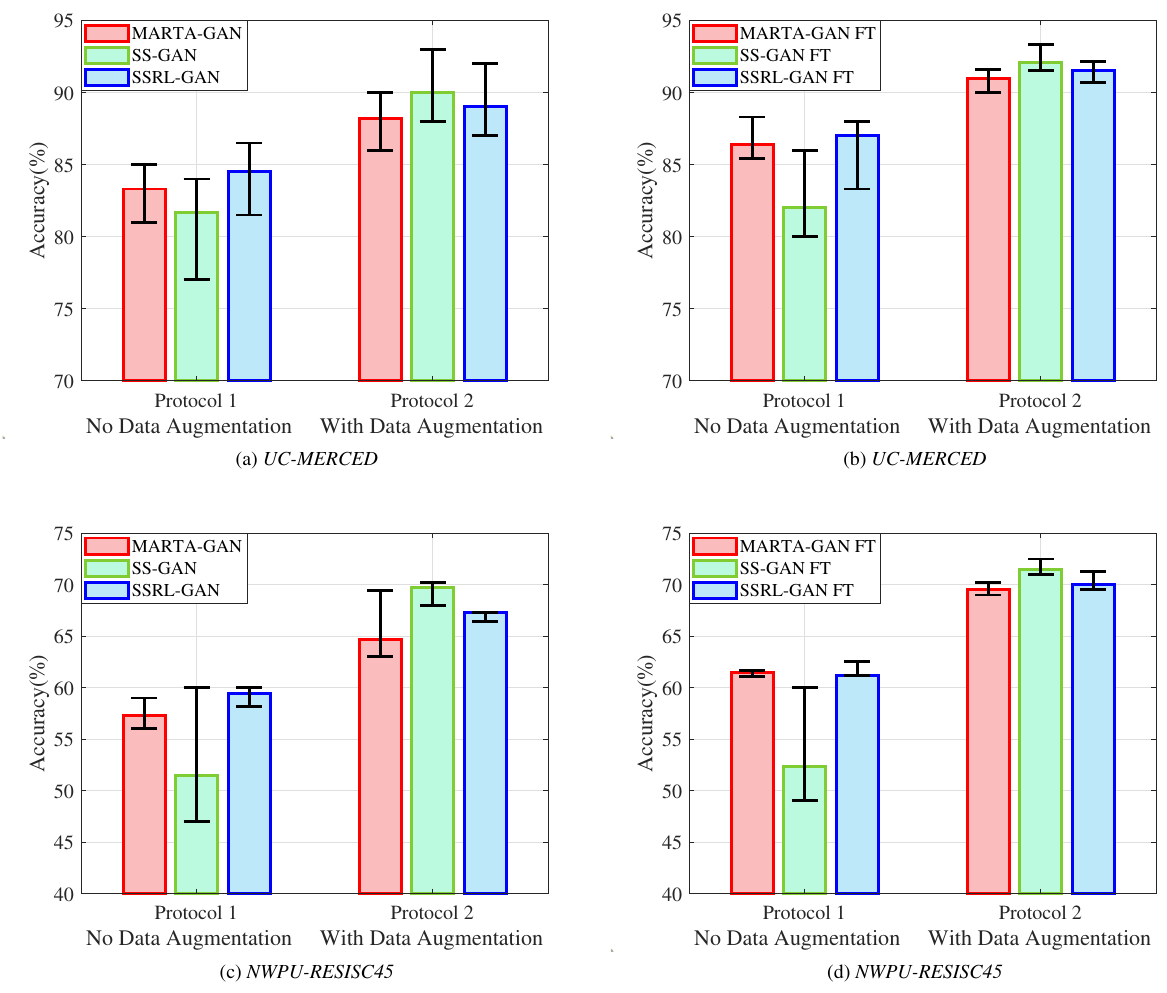
Figure 3. Overall Accuracy results in (%): FT in the plots on the right indicates